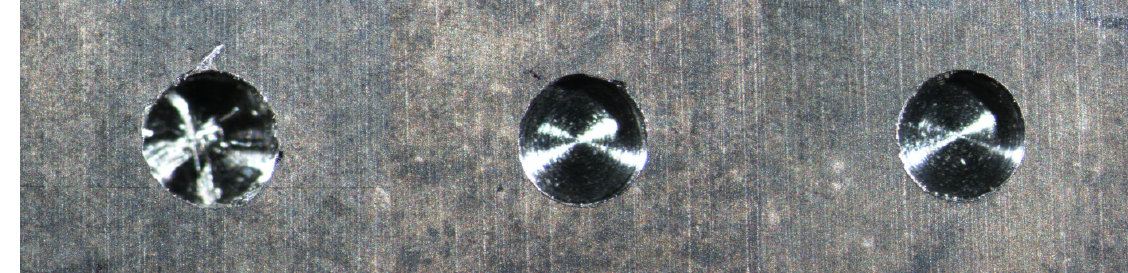
Figure 9: Image of the drilled holes obtained at the optical microscope